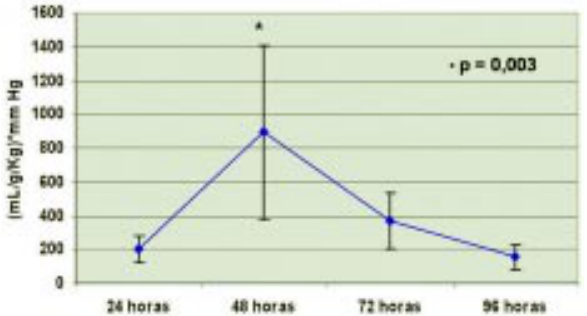
Fig. 8 - Gráfico da tensão de parede do VD ao longo do protocolo de sobrecarga sistólica intermitente. Valores (mmHg.ml.g -1 . Kg -1 ) = média ± desvio padrão; * p=0,003